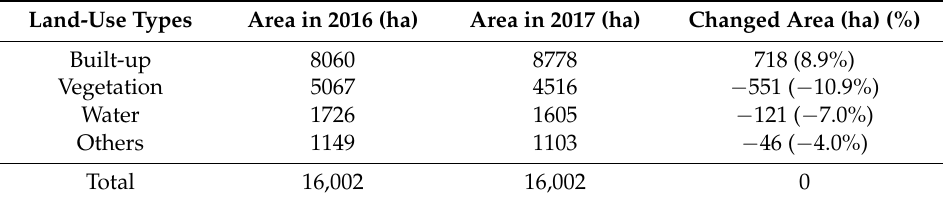
Table 5. Land-use changes between years 2016 and 2017 in inner Hanoi.